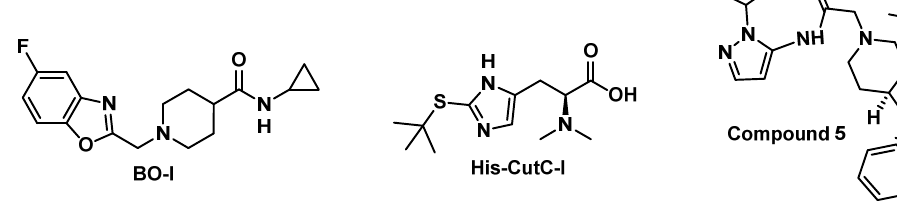
Figure 3. Chemical structures of BO ‐ I, His ‐ CutC ‐ I, and compound 5.